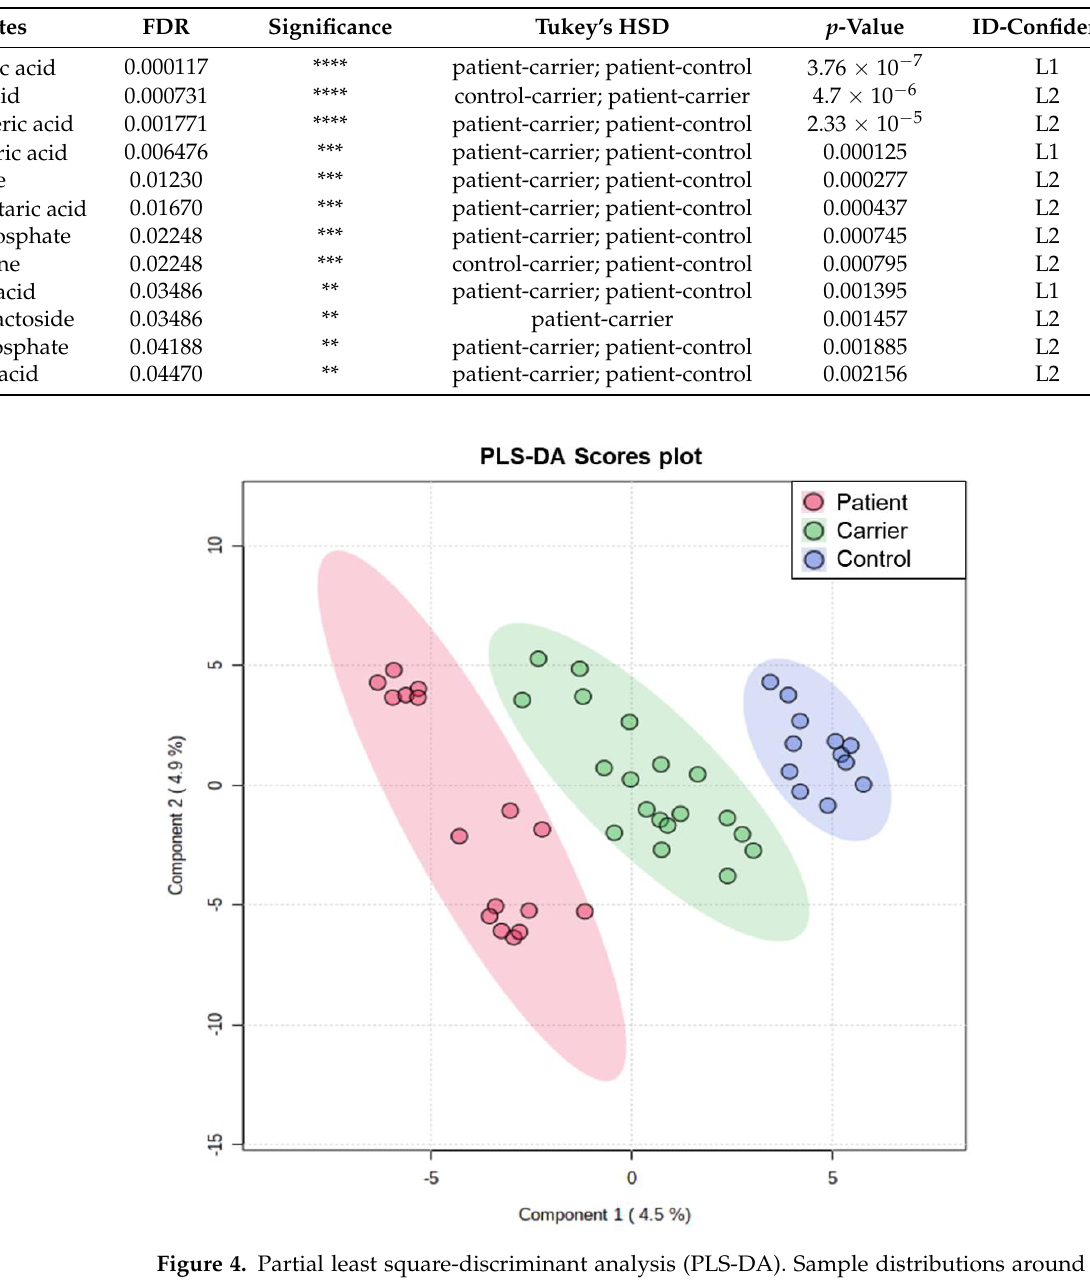
Table 3. Cytosolic metabolites significantly altered in erythrocytes of PKAN patients. List of tar- geted ( # ) and untargeted cytosolic metabolites with significant alterations in PKAN erythrocytes as compared to that of carrier and healthy donors. Normalized to the internal standard (targeted me- tabolites), or to mTIC (untargeted metabolites), one-way Anova with a Tukey’s HSD post hoc test and false discovery rate (FDR, cut-off ≤0.05 ) correction was performed using MetaboAnalyst as de- scribed in Section 2; ID confidence represents the level of metabolite identification (highest L1 to lowest L5) as described in Section 2. Asterisks denote significance between groups at p -Value (<0.05 (*), <0.01 (**), <0.001 (***), <0.0001 (****)).